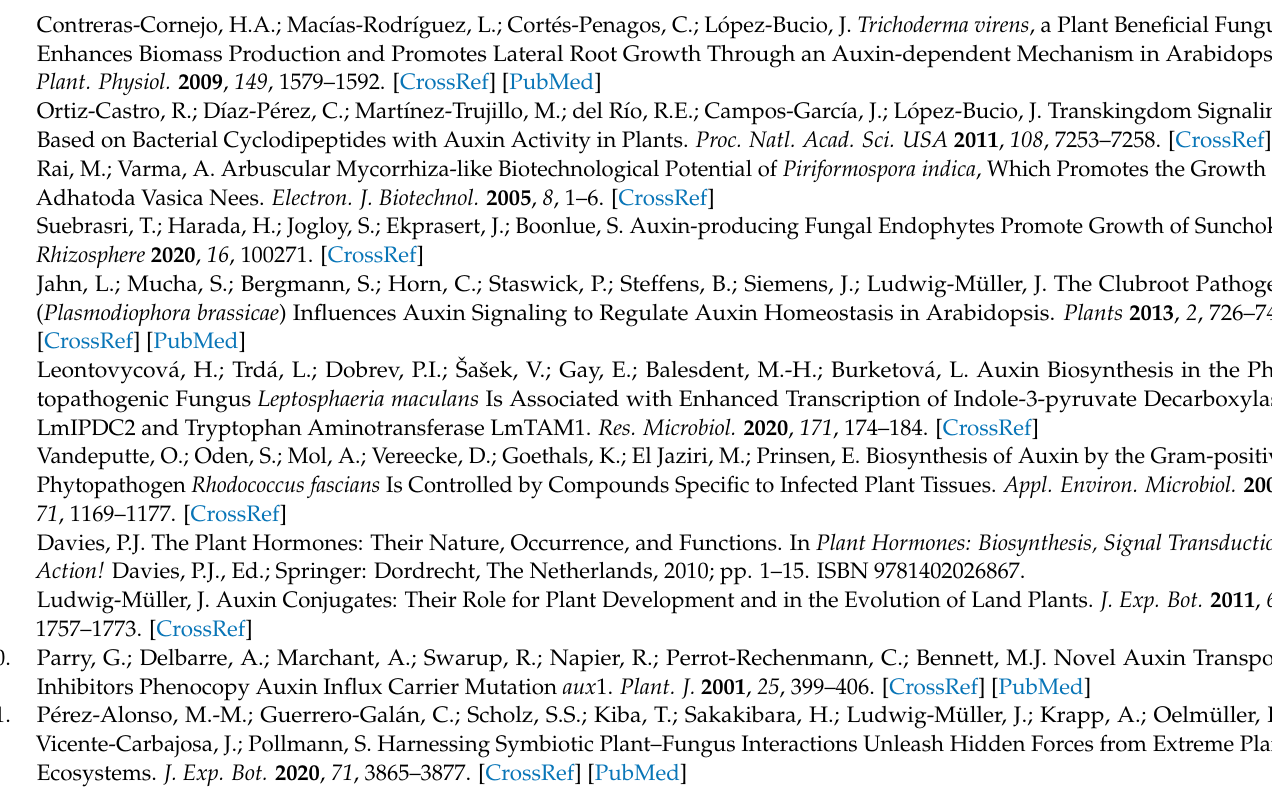
Table S1: Test statistics on IAA levels in medium and hyphae of C. asteris, using an unpaired t - test. Table S2: Test statistics on IAA levels in medium and hyphae of C. asteris in presence of IAA precursors, Table S3: Test statistics on IAA levels in medium and hyphae of C. asteris in the presence of MBI or YDF, Table S4: Test statistics on co-cultivation of A. thaliana and C. asteris on 10 µ M NOA or 10 µ M NPA, Table S5: Test statistics on co-cultivation of A. thaliana and C. asteris on 30 µ M NOA or 20 µ M NPA. Table S6: Raw